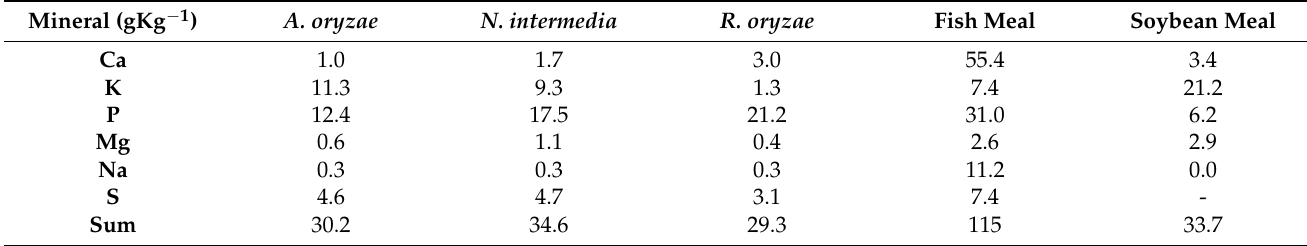
Table 3. Macromineral content of A. oryzae , N. intermedia and R. oryzae , fish meal and soybean